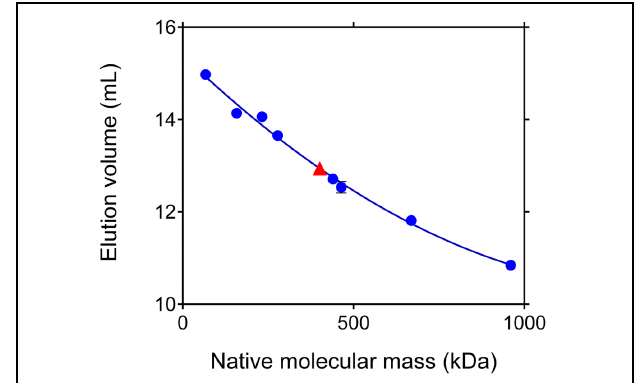
FIGURE 5 | Apparent molecular mass of rice P5C reductase under native conditions. Aliquots (100 μ L) of the purified protein, adjusted to 10 mg mL − 1 , were subjected to gel permeation chromatography on a Superose 12 HR 10/30 (Pharmacia) column that had been equilibrated with 50 mM Tris–HCl buffer, pH 7.75, containing 250 mM NaCl. A molecular mass of 401 ± 19 kDa was estimated for P5C reductase. Based upon these results, the enzyme could consist of 13–14 subunits. Identical elution patterns were obtained at increasing NaCl concentration up to 1 M (data not shown).